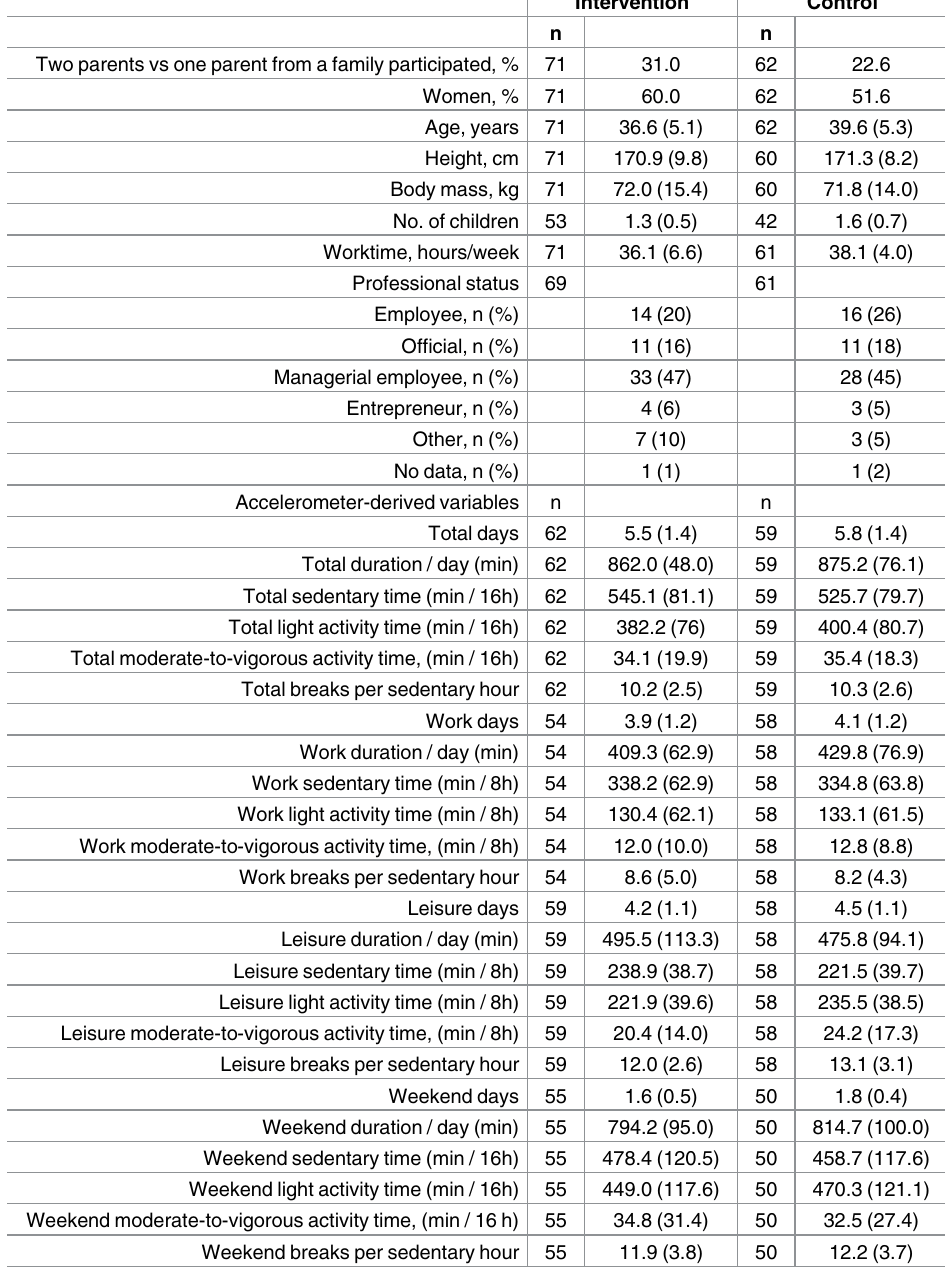
Table 1. Baseline characteristics of intervention and control group